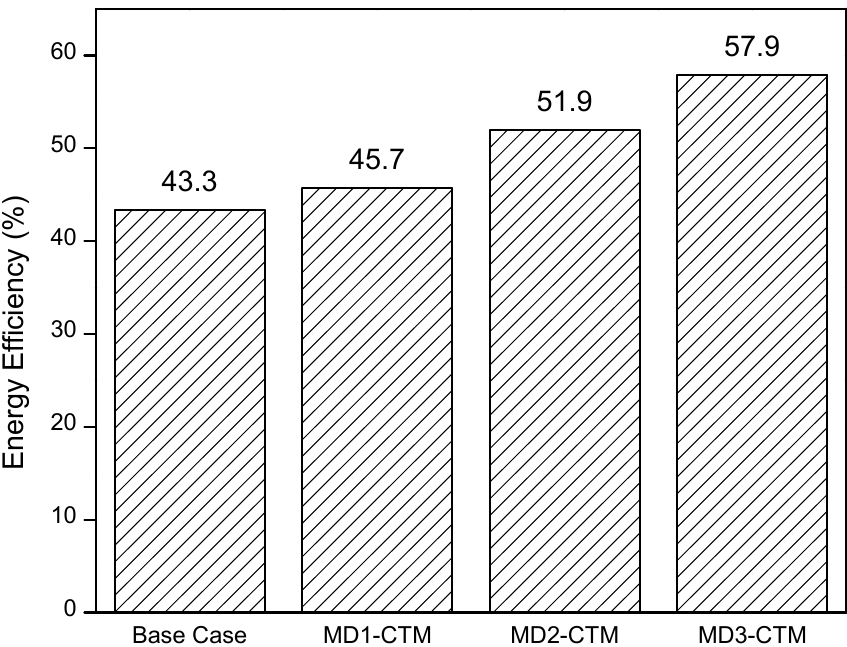
Figure 6. Energy efficiencies based on the first law of thermodynamics.